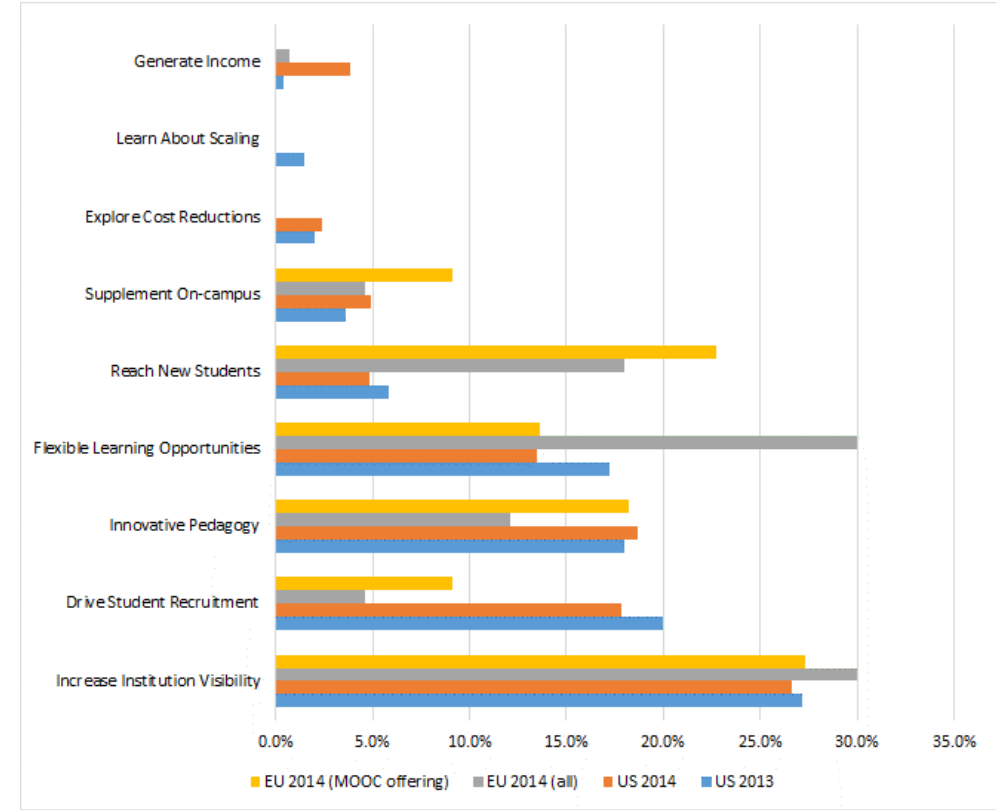
Figure 7 . Primary objectives to offer a